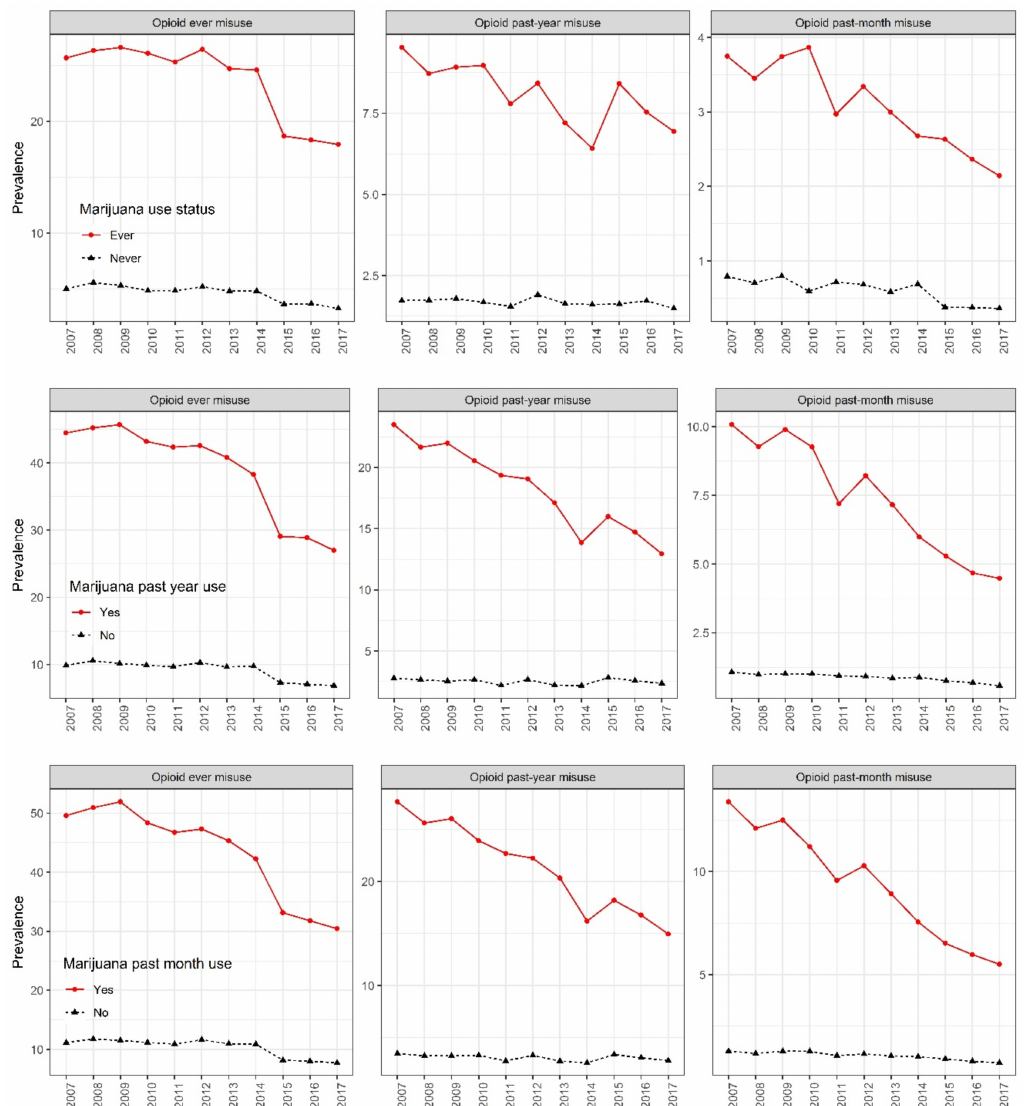
Figure 2. Prevalence of prescription-opioid misuse in the United States stratified by marijuana use status,